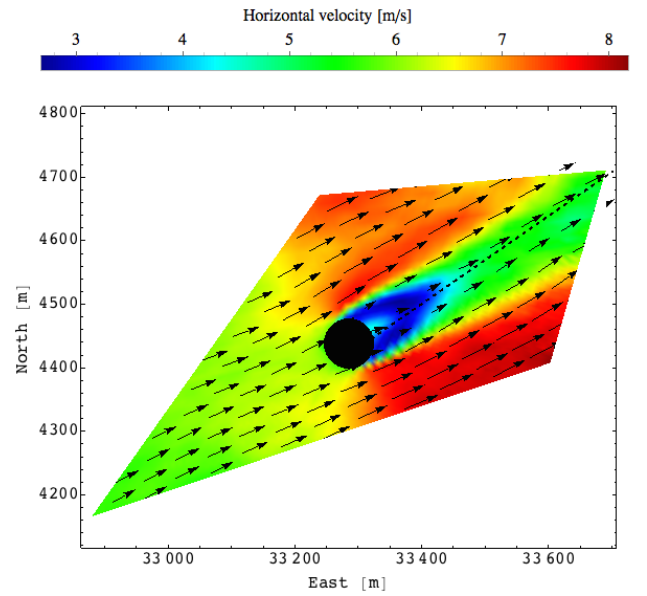
Figure 12. The result of 10-min averaged wake scans performed by two LRWS. The dashed line indicates an RHI scan plane (see Figure 11). The arrows represent the wind direction, while the black disc represents the area covered by the wind turbine